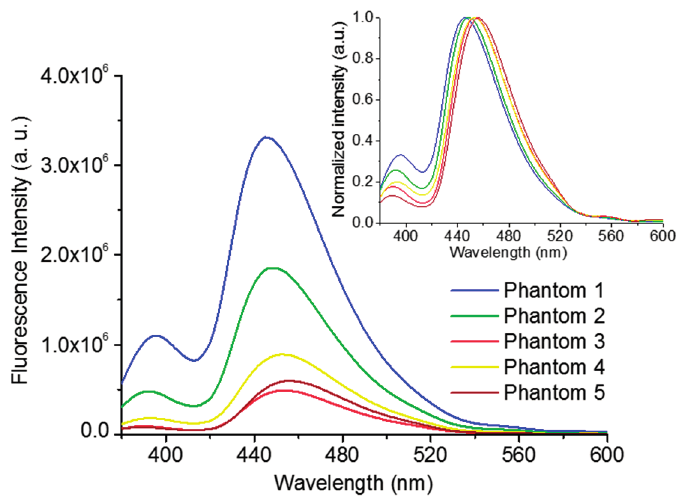
Figure 10. Bulk fluorescence spectra ( λ exc = 350 nm) for all phantoms created (Inset: Normalized